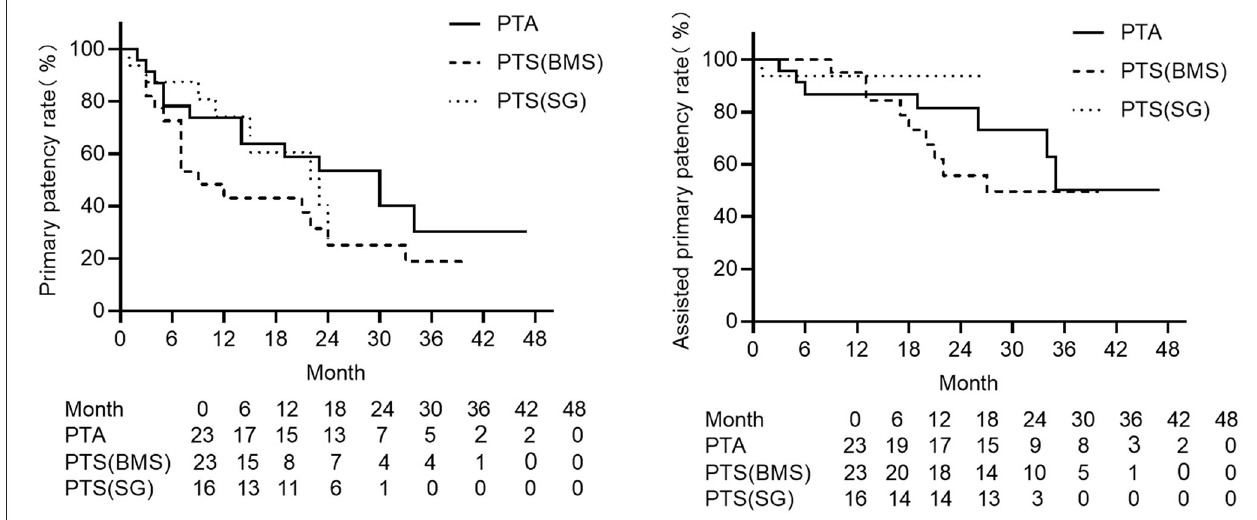
FIGURE 3 | The Kaplan–Meier curves of the primary patency (left) and assisted primary patency (right) for different interventions for central venous lesions. PTA is depicted with solid lines, PTS with bare stent with short segments, and PTS with stent graft with the dotted line. PTS with bare metal stent had a lower primary patency among 3 to 24 months compared with PTS with stent graft ( p = 0.011), and a lower primary patency after 13 months compared with PTS with stent graft (landmark analysis, p = 0.033).